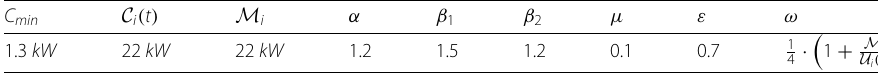
Table 4 Parameter configuration of the smart charging